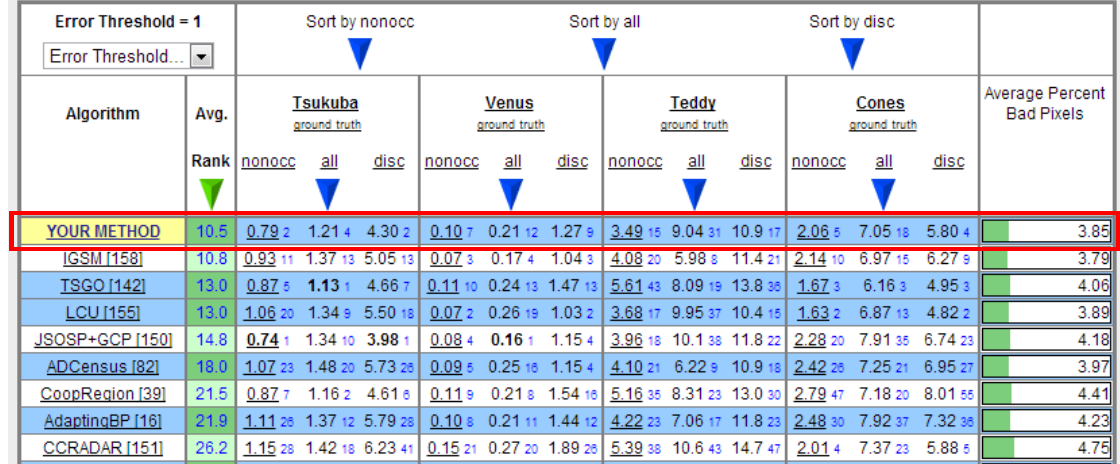
Figure 11. Middlebury results of our method. All numbers are the percentage of error pixels whose absolute disparity error is larger than one. The blue number is the ranking in every column. Our method outperforms the conventional stereo matching algorithms and ranks first among approximately 164 methods according to the average of the sum of the rankings in every column (up to 20 April